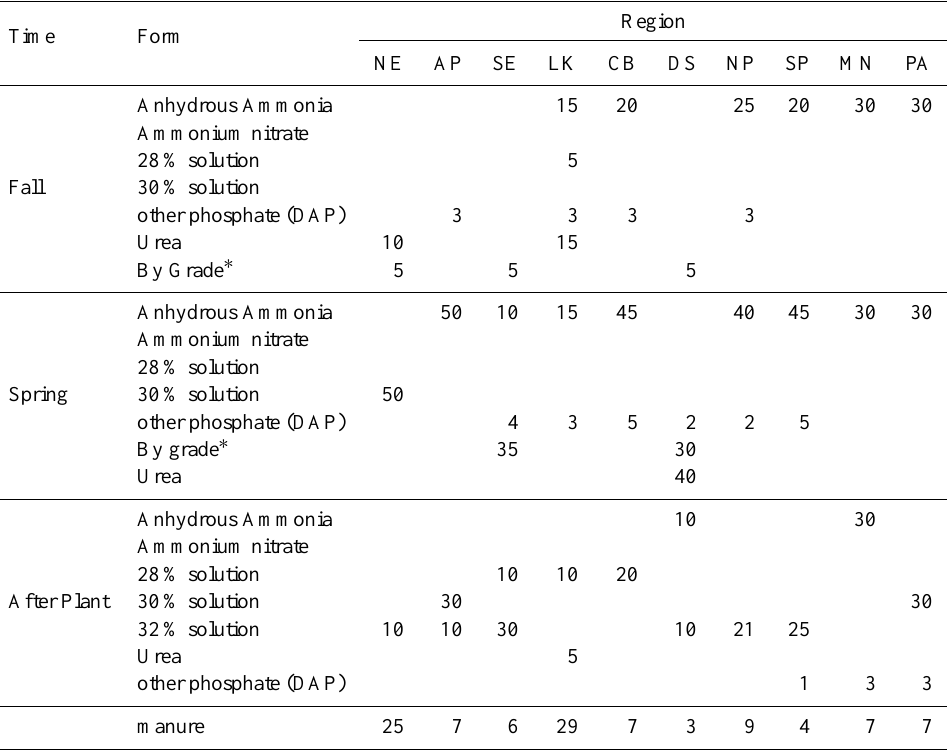
Table 1. Example of regional grain corn fertilizer amount, timing, form and distribution. Values are in percent of annual N needs met. LK = Lake States, CB = Corn Belt, NP = Northern Plains, SP = Southern Plains, DS = Delta States, SE = Southeast, AP = Appalachia, NE = northeast, MN = Mountain, PA = Pacific (see Fig. 2).